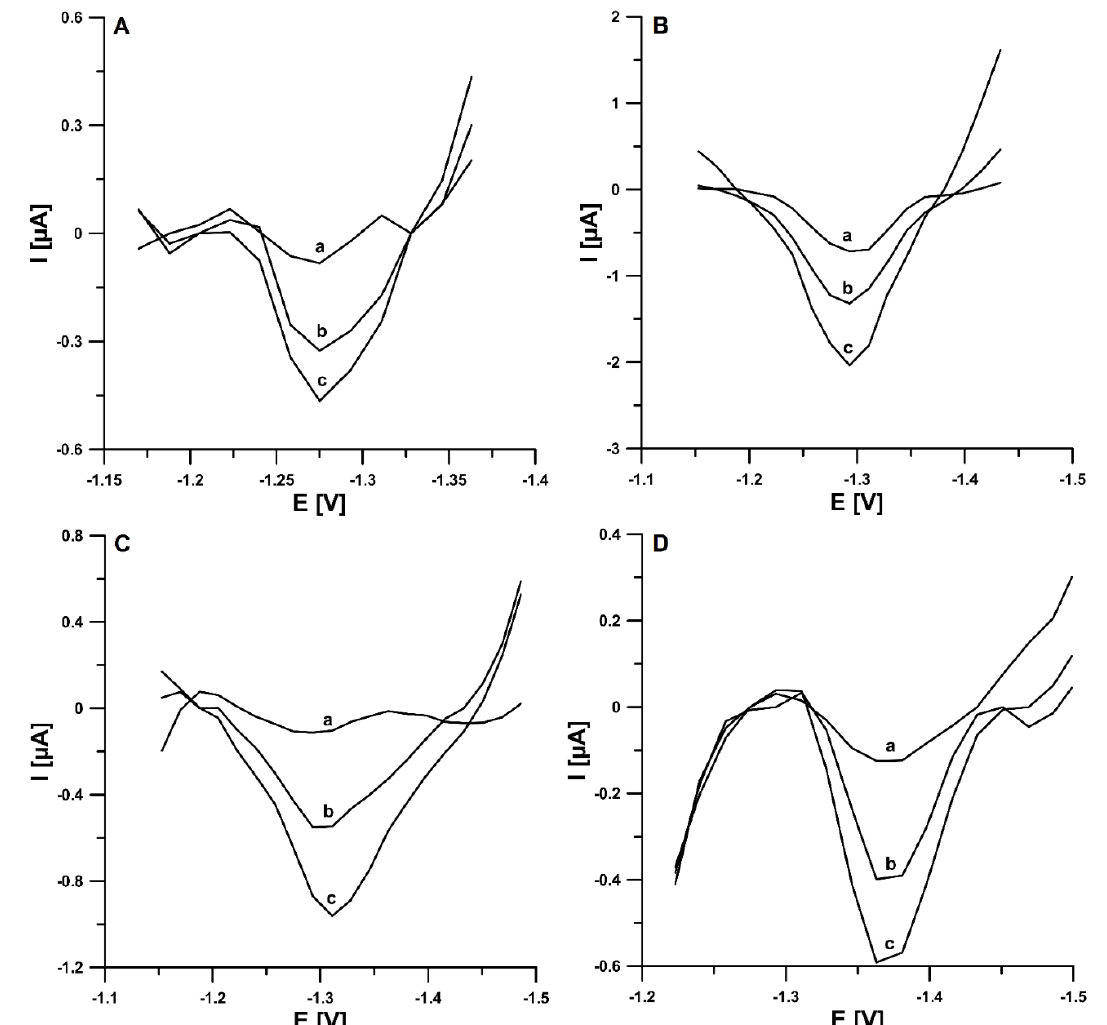
Figure 10. The DPAdSVs recorded for the determination of TST in reference material of human urine ( A , B ) and wastewater samples purified in a sewage treatment plant ( C , D ): ( A ): (a) 10 µL of